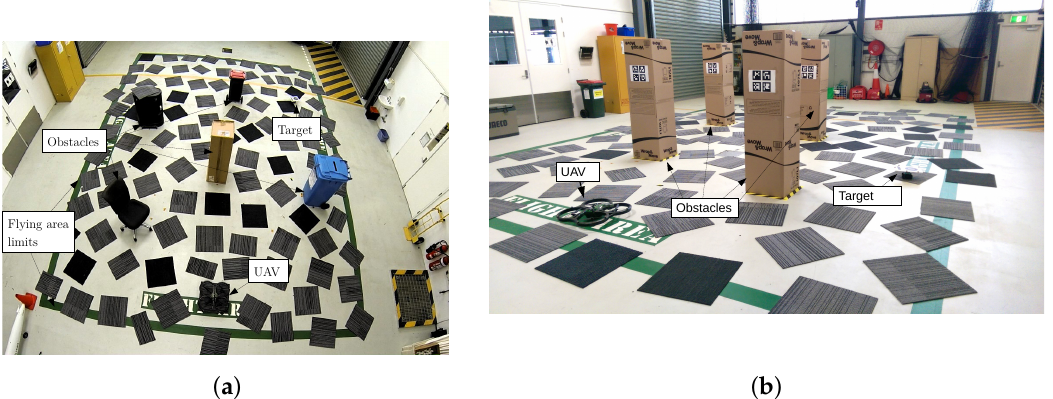
Figure 3. Two typical scenarios for the navigation and target detection problem. ( a ) Scenario with five obstacles; ( b ) scenario with four obstacles with Augmented Reality (AR)